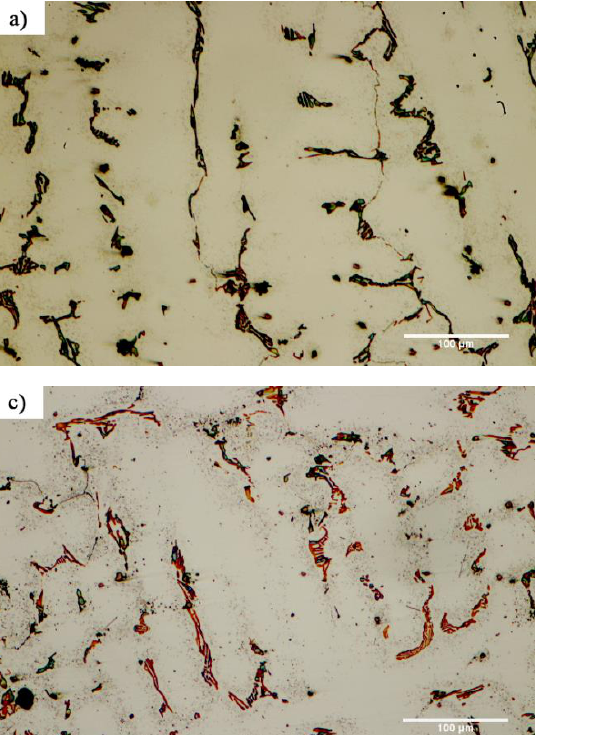
Figure 12. SEM micrographs of ( a ) fine M 23 C 6 carbide and ( b ) lamellar M 23 C 6 carbide and ( c , d ) EDX spectra of the corre- sponding phases.